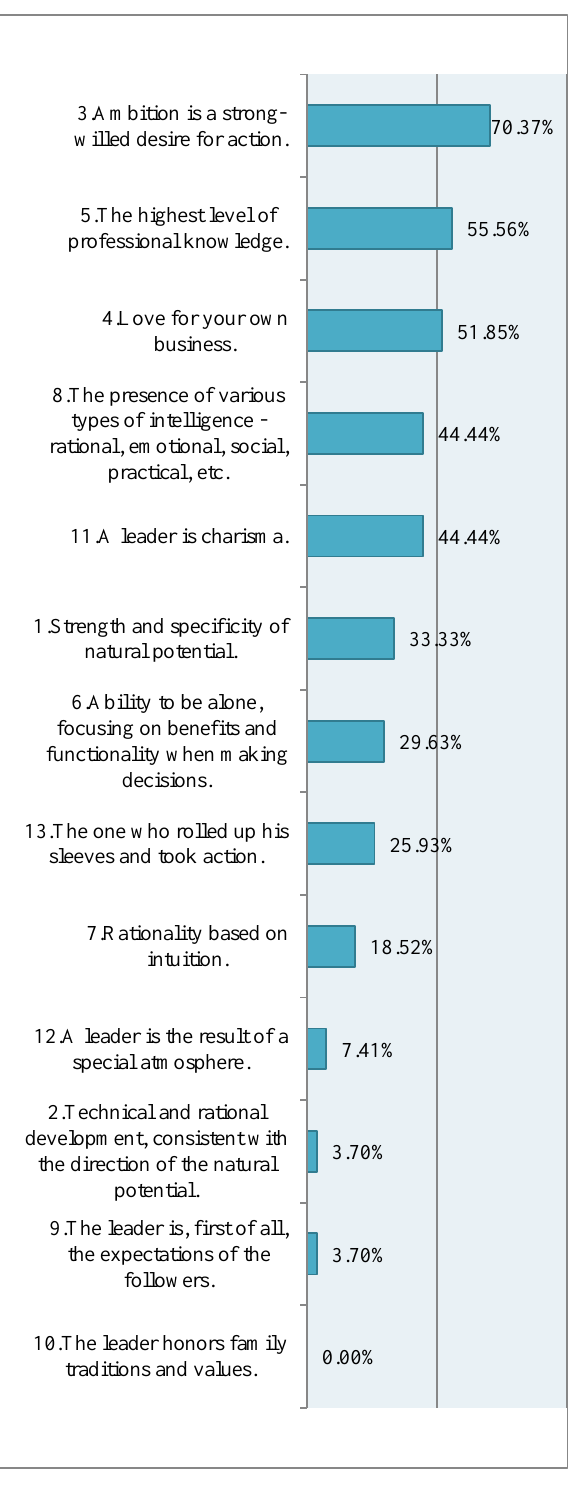
Fig. 6. The qualities necessary for an intellectual leader according to the